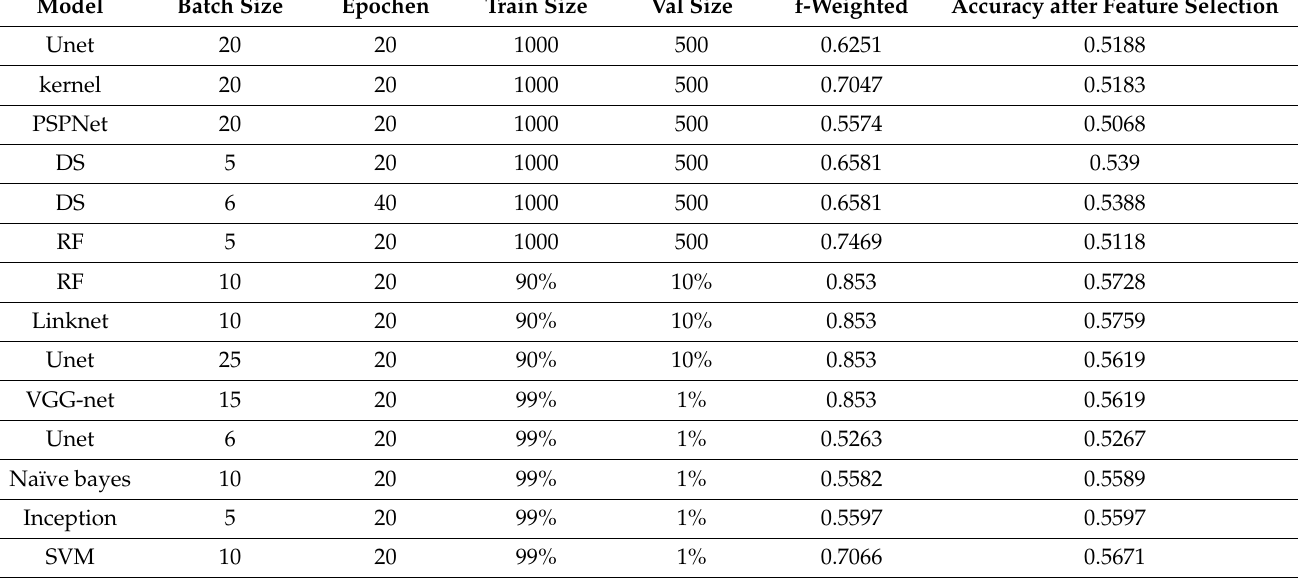
Table 5. Multi-model